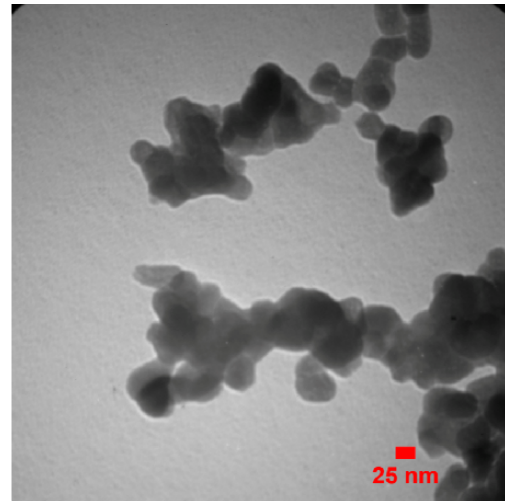
Fig. 1: TEM image of the prepared adsorbent with mean diameter of 40 nm.